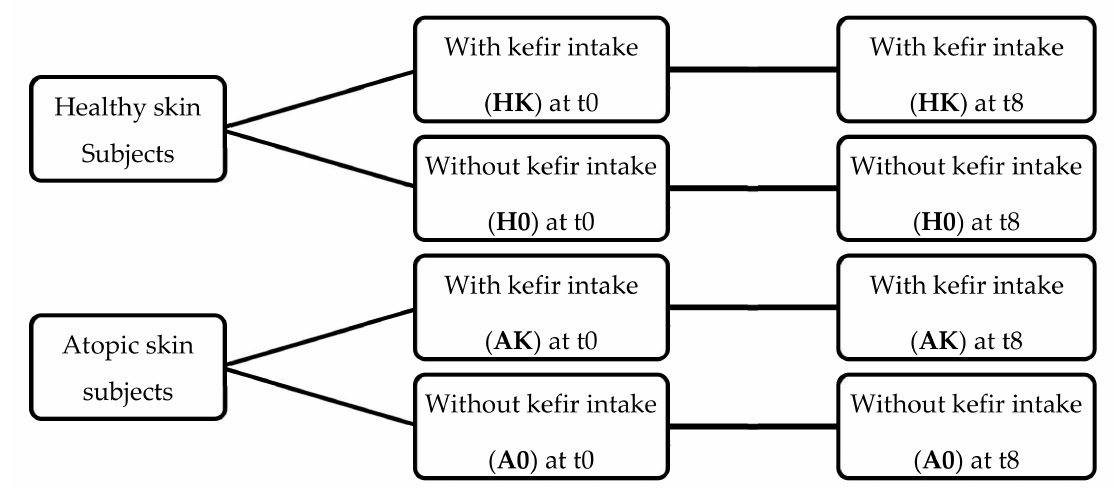
Figure 1. Study design regarding skin conditions and kefir intake during the eight-week intervention period: HK—healthy skin with kefir intake; H0—healthy skin without kefir intake; AK—atopic skin with kefir intake; A0—atopic skin without kefir